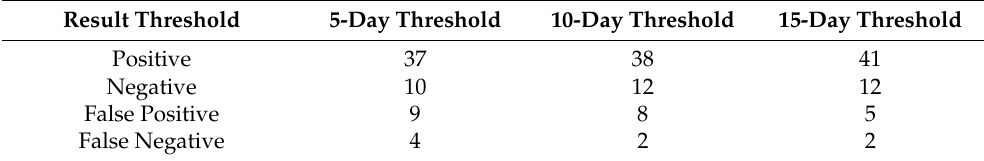
Table 1. Validation results of different threshold. Result